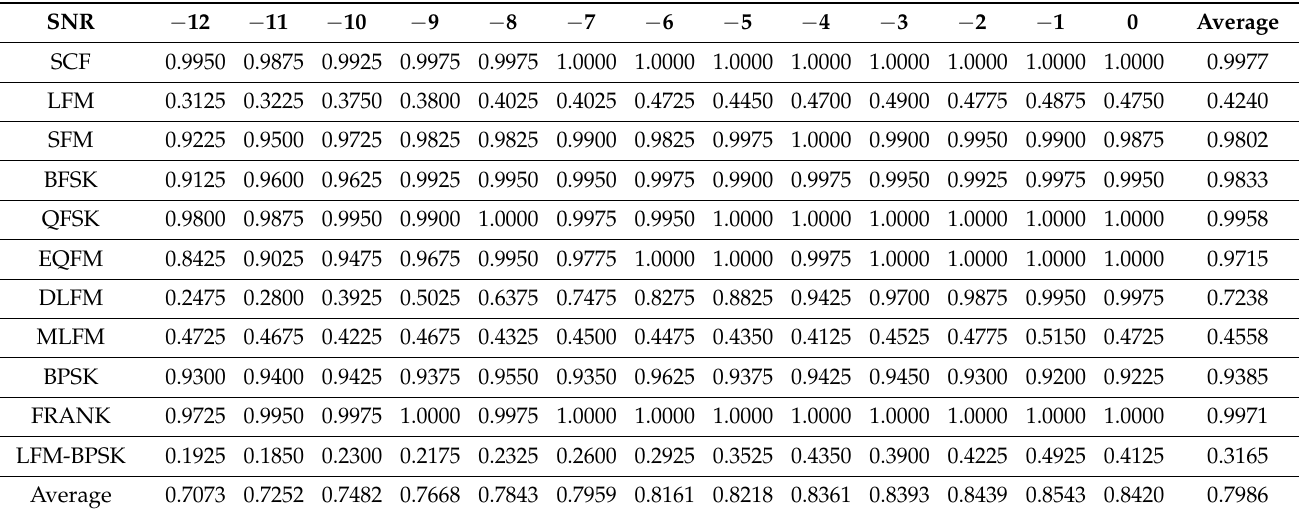
Table A13. Semi-supervised classification results with the datasets in Situation Dataset 5 without self-paced data augmentation ( T cycle = 26, NUM = 2145).